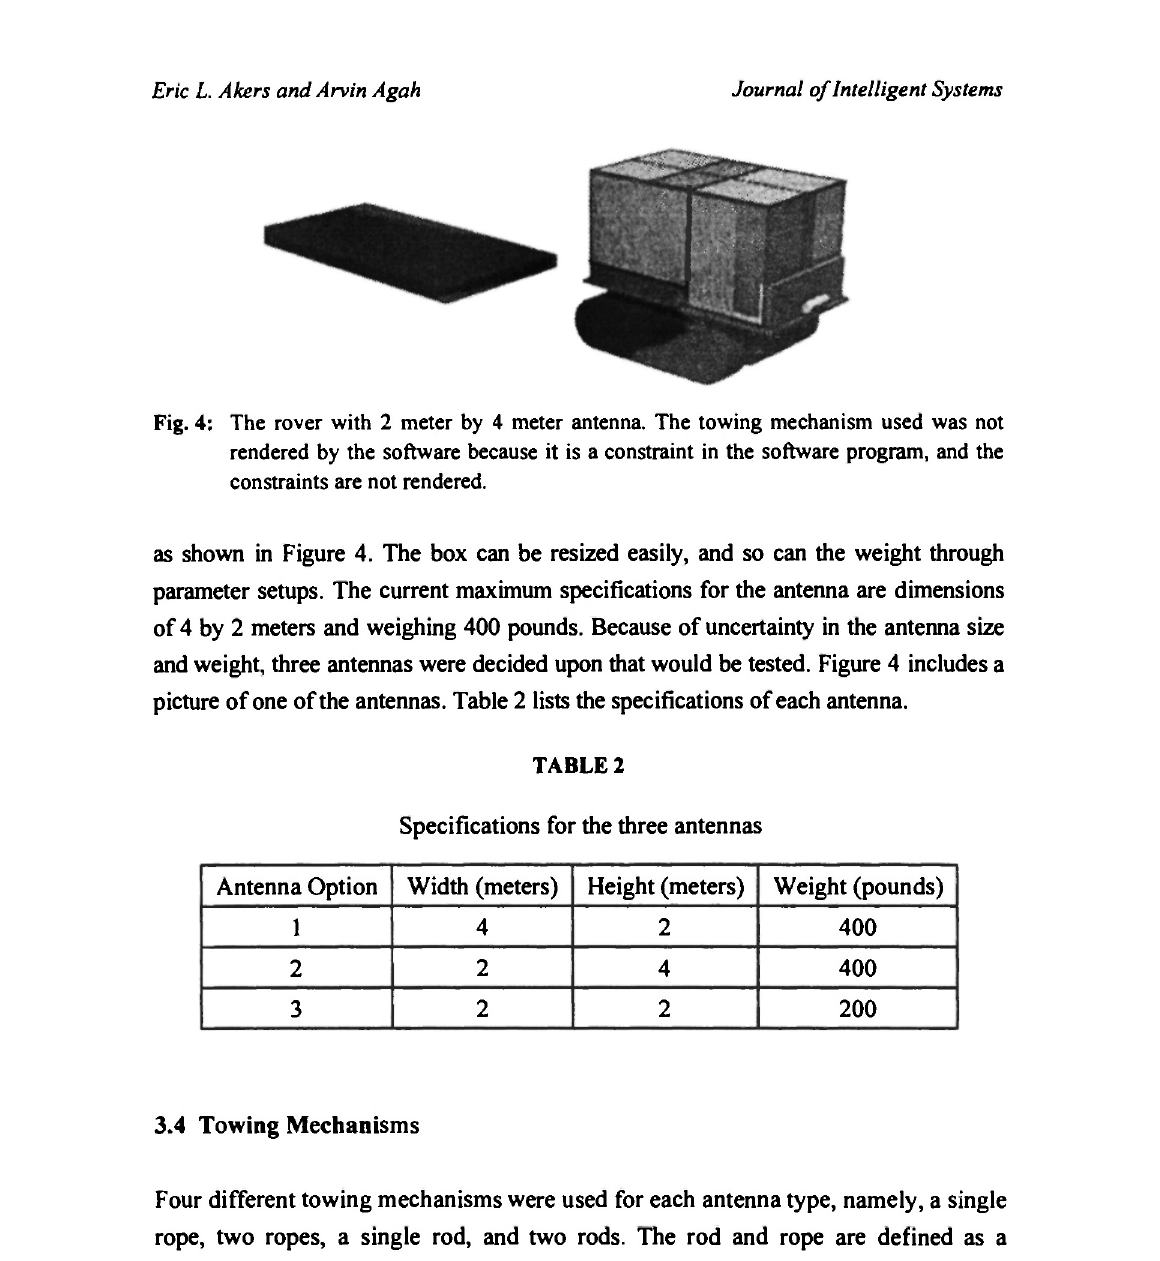
Fig. 4: The rover with 2 meter by 4 meter antenna. The towing mechanism used was not rendered by the software because it is a constraint in the software program, and the constraints are not rendered.